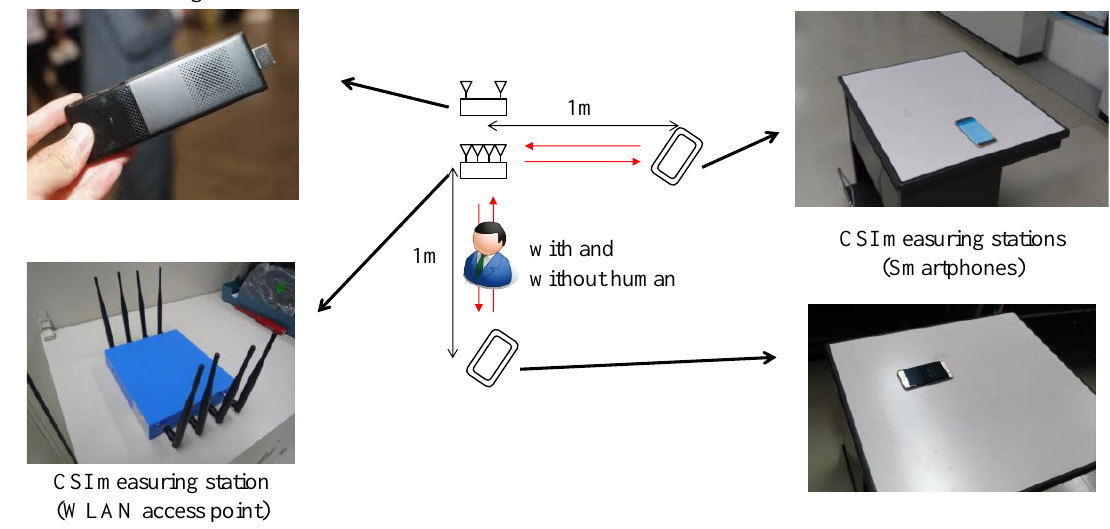
Figure 5. System configuration.